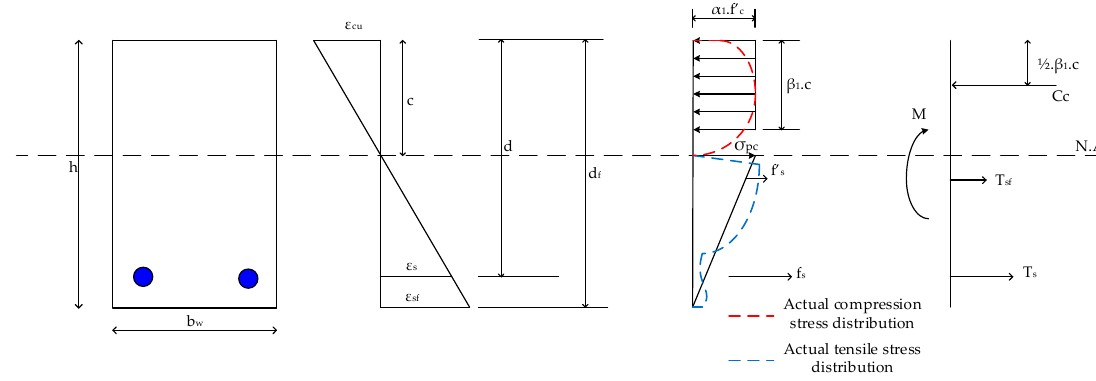
Figure 7. General strain, idealized stress distribution, and internal force of steel fiber-reinforced concrete (SFRC) beam section [41].